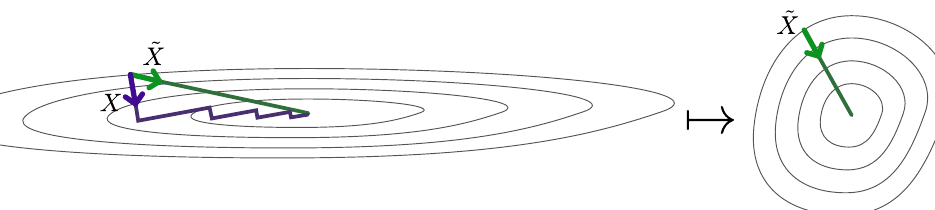
Figure 1: On the left, the grey ovals are the contour lines of the cost function in this 2-dimensional optimisation problem. The purple arrow X is the negative gradient, and the zig-zag line emanating from it is the path that gradient descent takes. The relatively slow convergence of the gradient descent path is a consequence of the near-singular geometry of the contour lines, where the cost function varies much more along one axis than the other. The green arrow ˜ X would be the optimal choice for the preconditioned search direction, the one that takes us to the optimum in a single retraction. By changing the geometry (i.e. the metric) of the problem, in this case by a simple rescaling of the axes, we can map to the problem on the right, where the geometry of the contour lines has become less singular. In this new geometry ˜ X is in fact the negative gradient. This suggests that a preconditioner that implements this change of geometry would probably be beneficial for convergence. While the above is a cartoon example, redefining the metric to make the optimisation landscape less singular can be a useful way to design preconditioners more